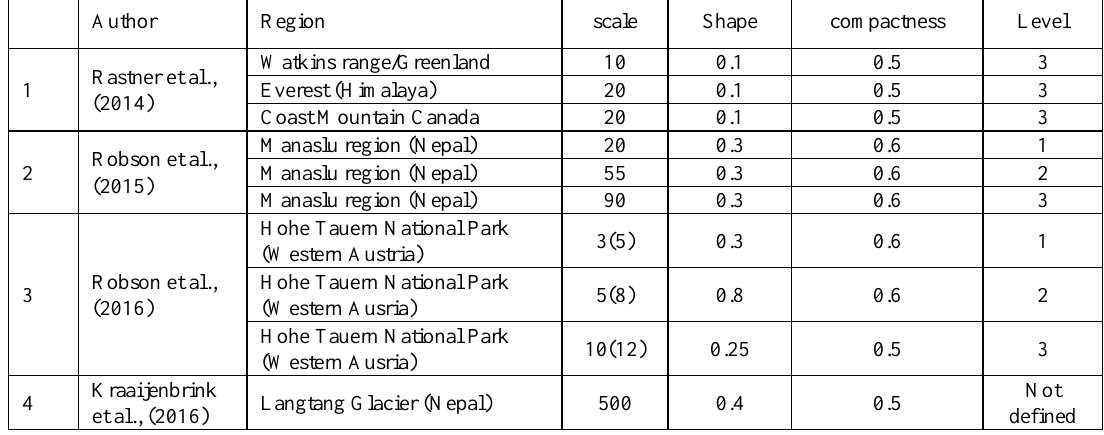
Table 3. Analysis of parameter used in MRIS